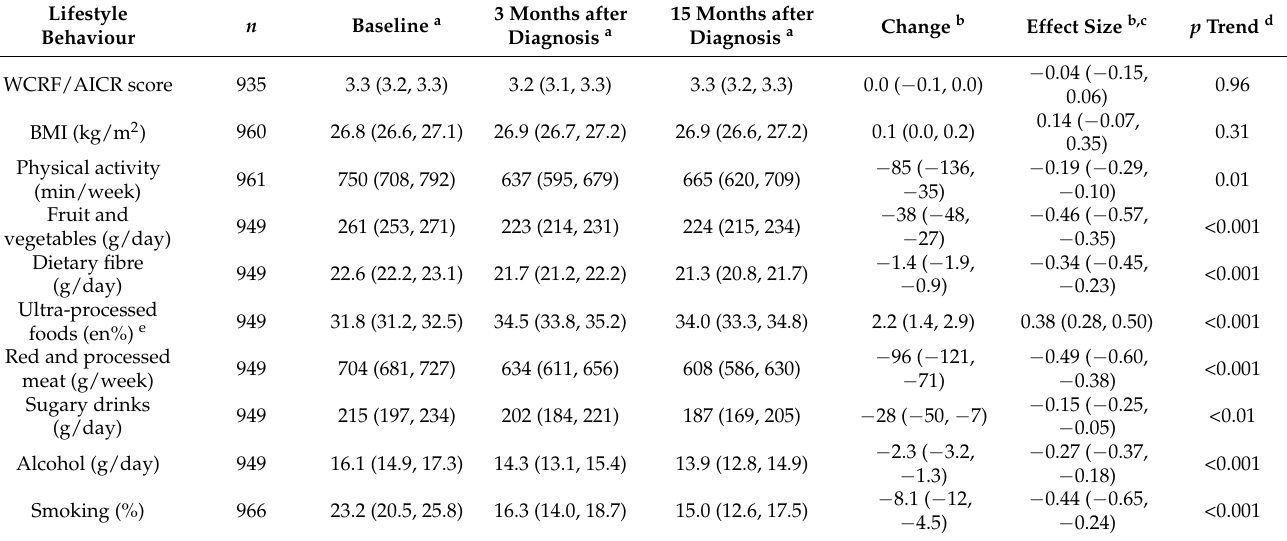
Table 3. Change in lifestyle behaviours in the first fifteen months after diagnosis with non-muscle- invasive bladder cancer.